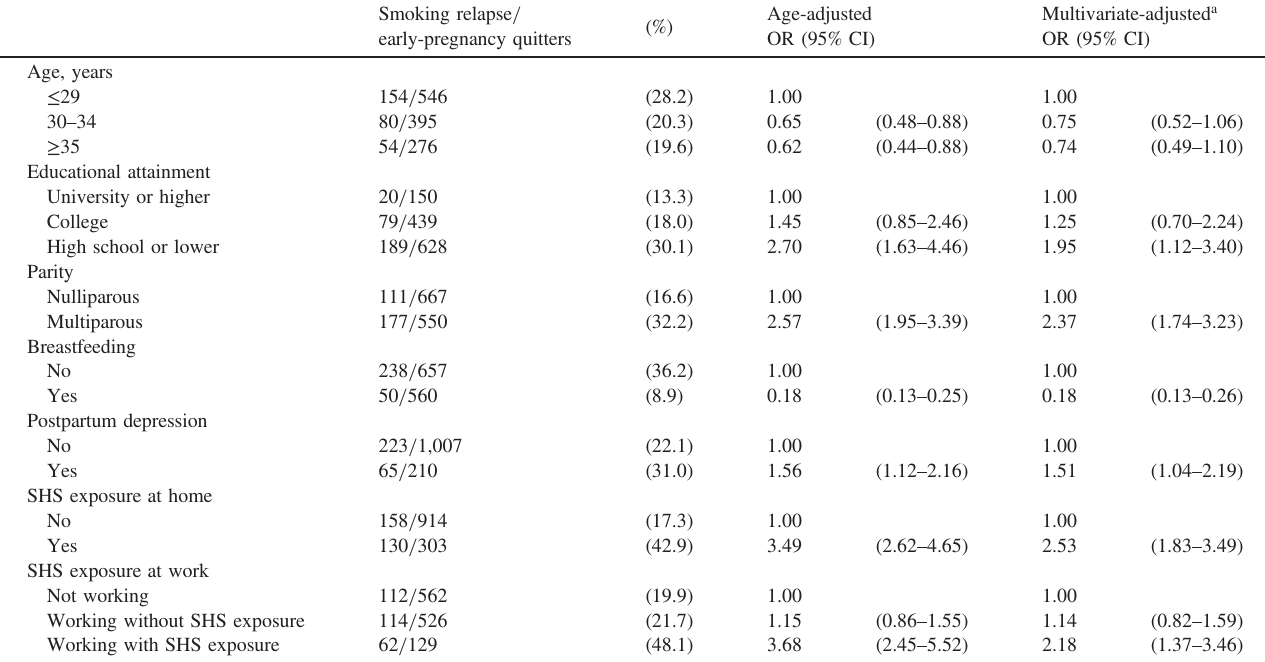
Table 2. Prevalence, OR and 95% CI for smoking relapse by 1 year postpartum among women who quit in early pregnancy ( n = 1,217)